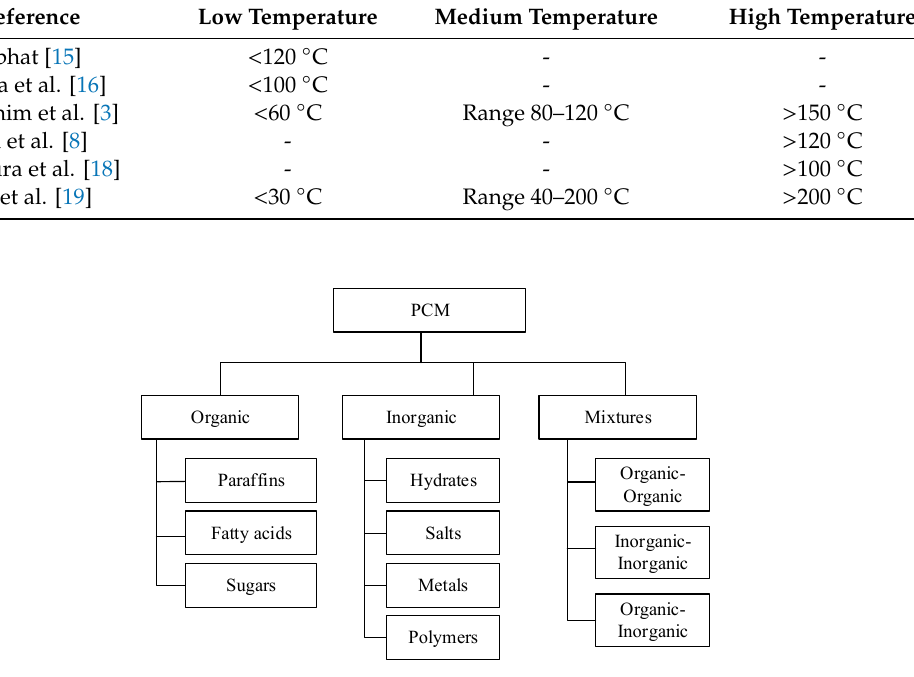
Figure 1. Phase change materials classification according to composition.